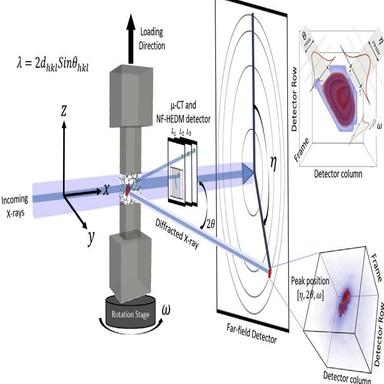
Schematic of the experimental setup featuring a suite of X-ray characterization techniques which include m-CT, NF-HEDM, FF-HEDM, and reciprocal space mapping.